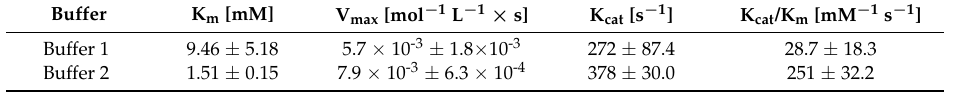
Table 4. Comparison of kinetic characteristics measured with plant HRP Type VI-A in two different buffers. Buffer